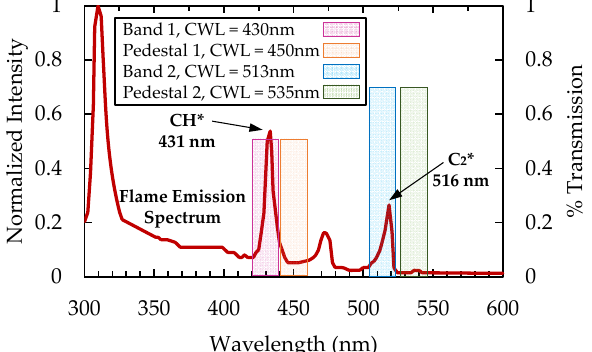
Figure 1. Example of an emission spectrum from a propane–air flame with highlighted regions for optical filtering.